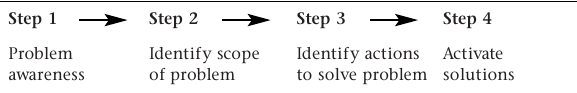
Figure 2: Steps for managing workplace